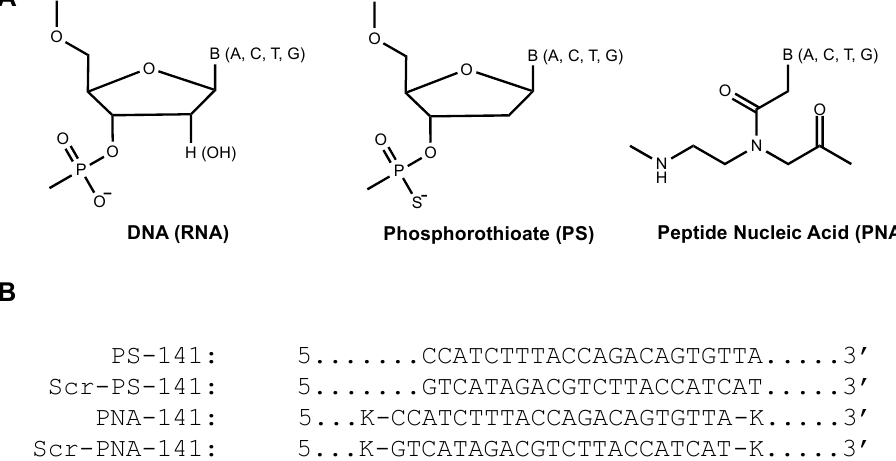
Figure 1. ( A ) Chemical structure of DNA and RNA, Phosphorothioate (PS) and Peptide Nucleic acid (PNA) units. DNA (RNA) and PS contain a negatively charged backbone. In comparison to DNA, in PS, non-bridging oxygen (O) of the phosphate group is replaced by a sulfur (S). PNA has a neutral backbone containing 2-aminoethyl glycine units on which the nucleobases are attached by methyl carbonyl linker. The natural nucleobases Adenine (A), Cytosine (C), Thymine (T), Guanine (G) are denoted as B. ( B ) The oligomer sequences PS-141 and PNA-141 to target miR-141-3p. Scrambled (Scr) are the controls designed for the study. Lysine residues (K) are attached at both ends of the PNAs sequences.